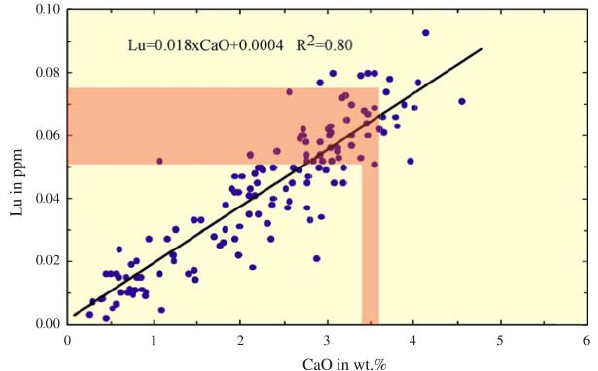
Fig. 21. Lu variations with CaO in anhydrous spinel peridotites. Mantle Lu is inferred assuming 3.50wt% CaO for the depleted mantle. From Salters and Stracke (2004). Copyright American Geophysical Union.